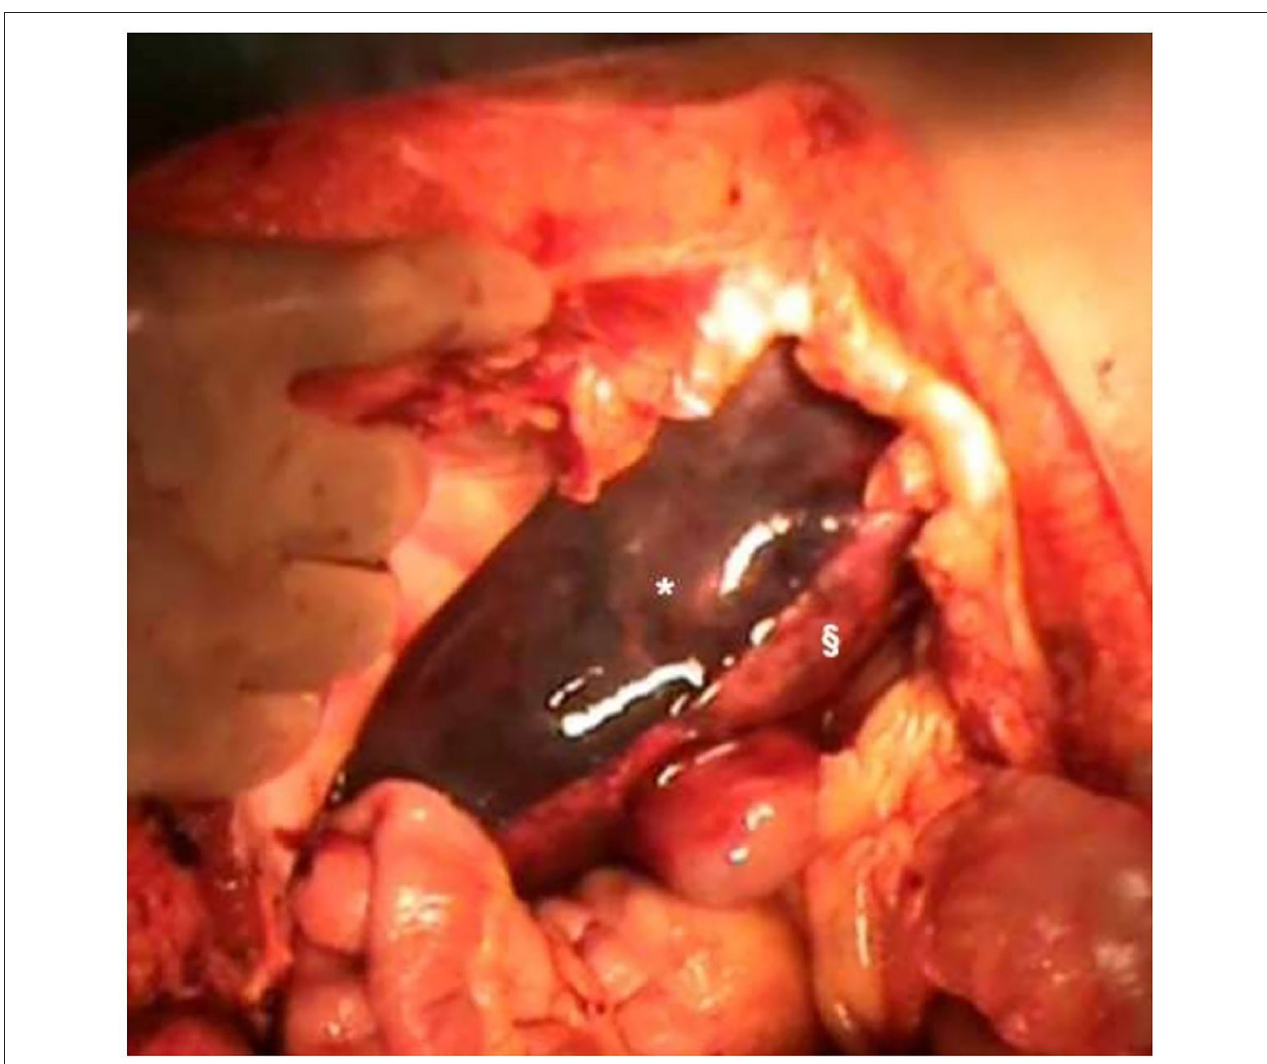
FIGURE 2 | Right liver haematoma and liver ischaemia during the first laparotomy after haemoperitoneum evacuation. * Right liver haematoma; § Right liver